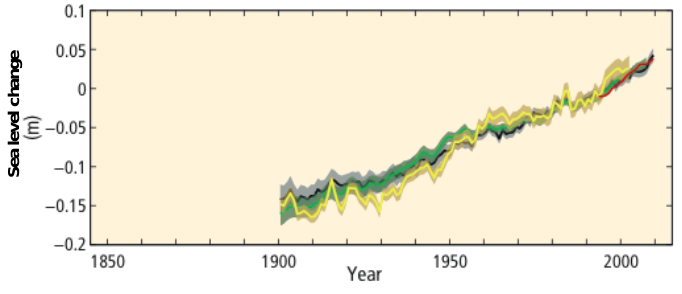
Figure 10. Global average sea level change, modified from [29].